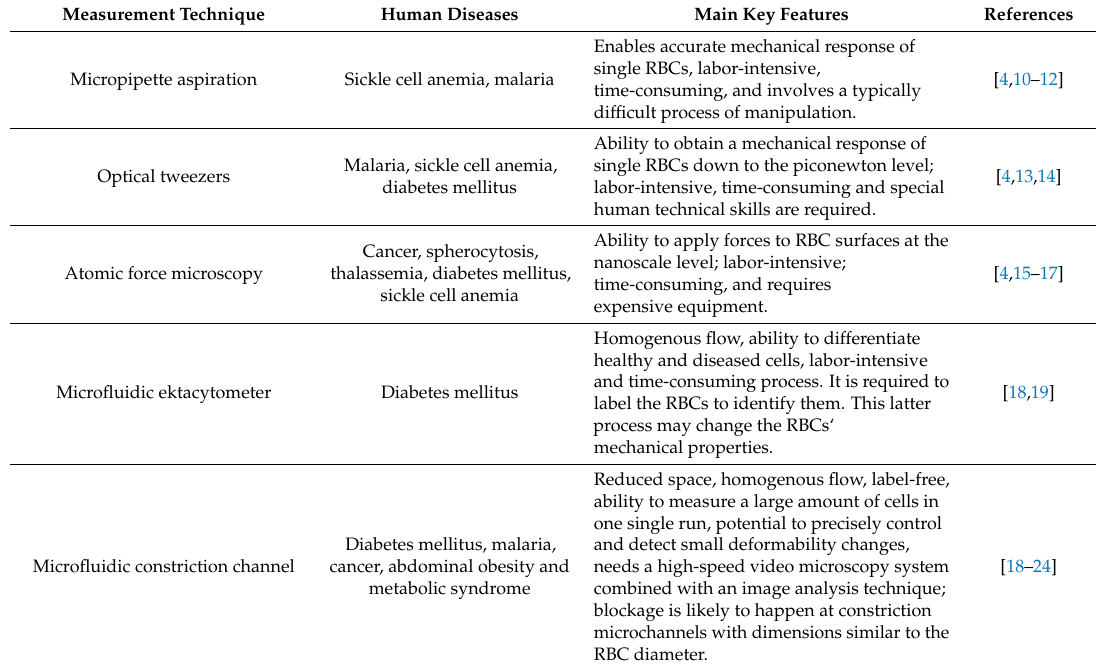
Table 1. Techniques to measure RBC deformability under different diseased